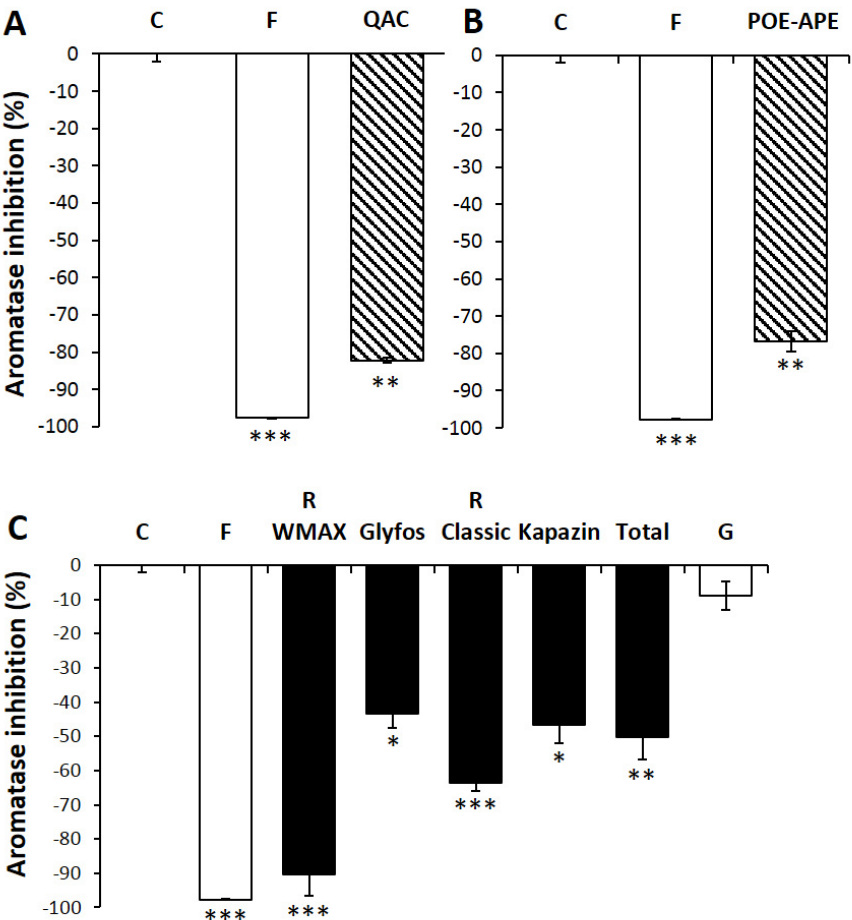
Figure 5. Inhibition of aromatase by co-formulants and formulations. * p < 0.05, ** p < 0.01, *** p < 0.001. ( A ) 25 ppm of the co-formulant QAC is compared to the negative control (C) and to the positive control formestane (F); ( B ) 100 ppm of the co-formulant POE-APE is compared to the negative control (C) and to the positive control formestane (F); ( C ) 50 ppm of formulations of glyphosate-based herbicides R WeatherMAX—R WMAX—Glyfos, R Classic, Kapazin and Total is compared to the negative control (C) and to the positive control formestane (F). Glyphosate alone (isopropyl ammonium salt form) was also tested at its dose present in the formulations (24.3